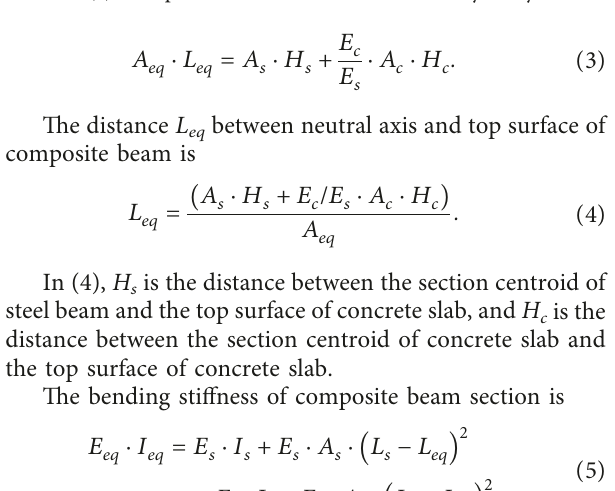
Figure 2: Plane layout of composite beam with CDS or UDS. (a) Composite beam with UDS. (b) Composite beam with CDS with interlaced notches. (c) Composite beam with CDS with neatly arrayed